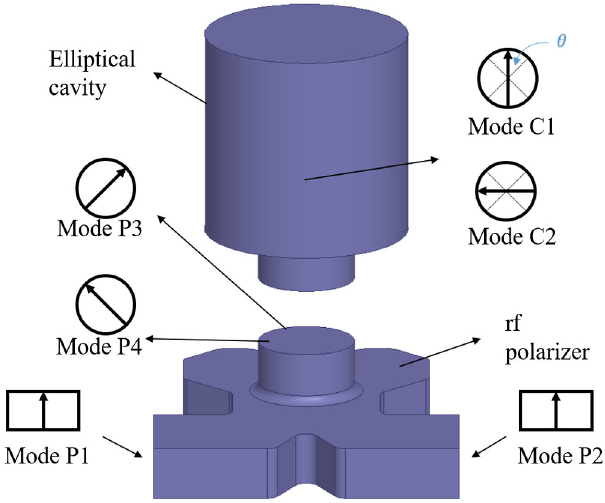
FIG. 19. Scheme of the pulse compressor with an elliptical cavity. Mode P i denotes the port modes of the waveguide, and mode C i denotes the polarized eigenmodes of the